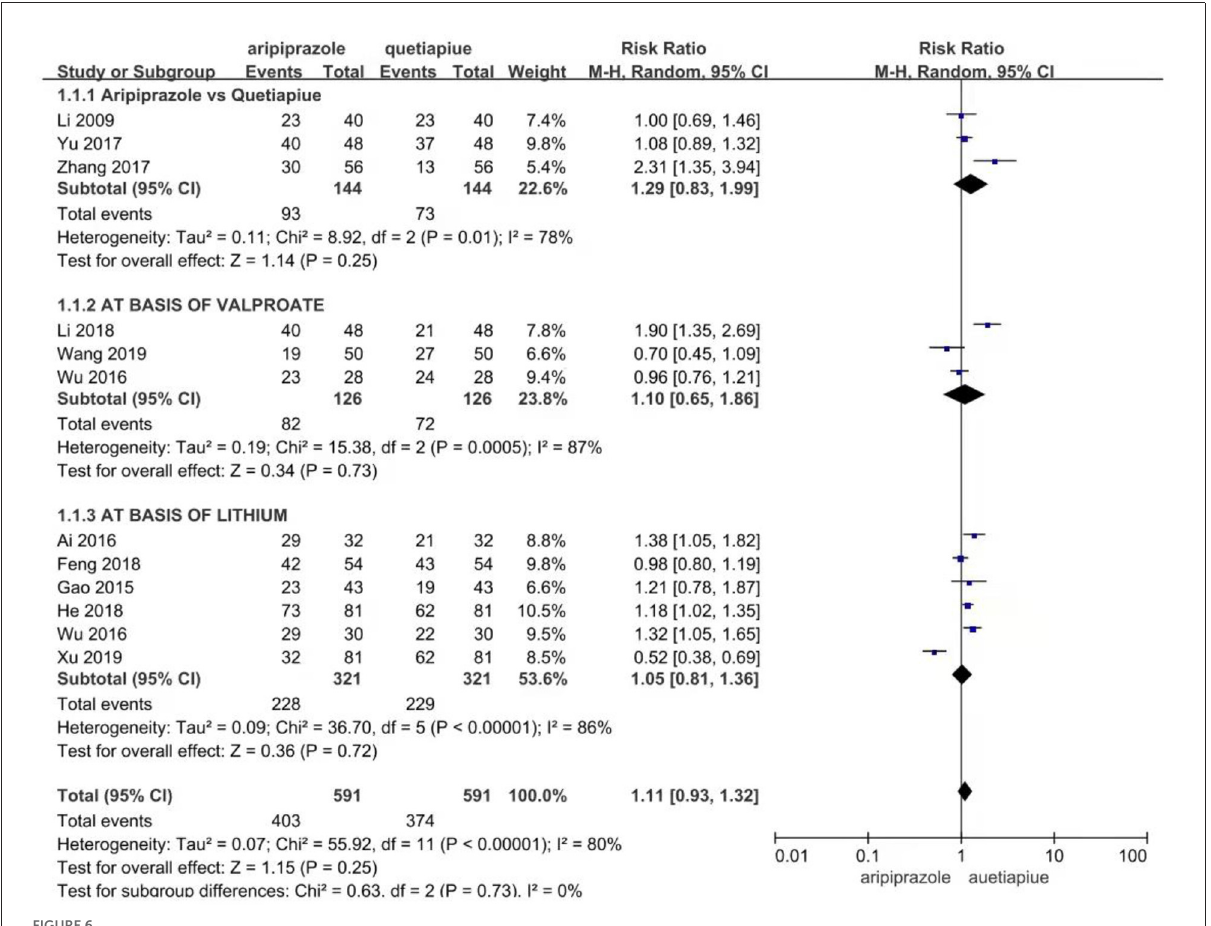
FIGURE6 Comparison of effective rate between aripiprazle and quetiapine in different subgroup. In case of no combination therapies, the results also still showed that the effective rate of aripiprazole in the treatment of bipolar depression was similar to quetiapine (93/144 vs. 73/144, Z = 1.14, P = 0.251) by random effect model. However, in the combination therapies with mood stabilizer of valproate salt, the effective rate of aripiprazole war smilar to quetiapine in the treatment of bipolar depression (82/126 vs. &2/126, Z = 0.34, P = 0.72) by random effect model. In the combination therapies with mood stabilizer of lithium carbonate, the effective rate of aripiprazole war similar to quetiapine in the treatment of bipolar depression (228/321 vs. 229/321, Z = 0.36, P = 0.72) by random effect